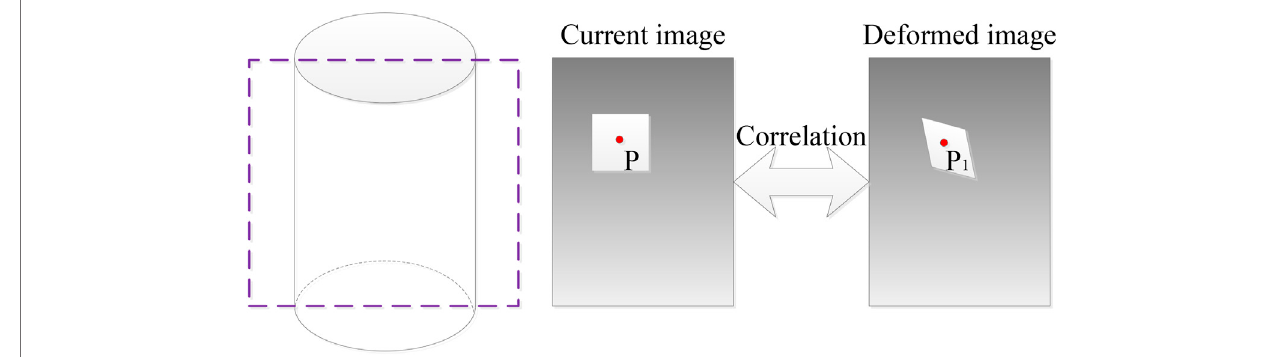
FIGURE 3 | Schematic diagram of the principle of the DIC method.